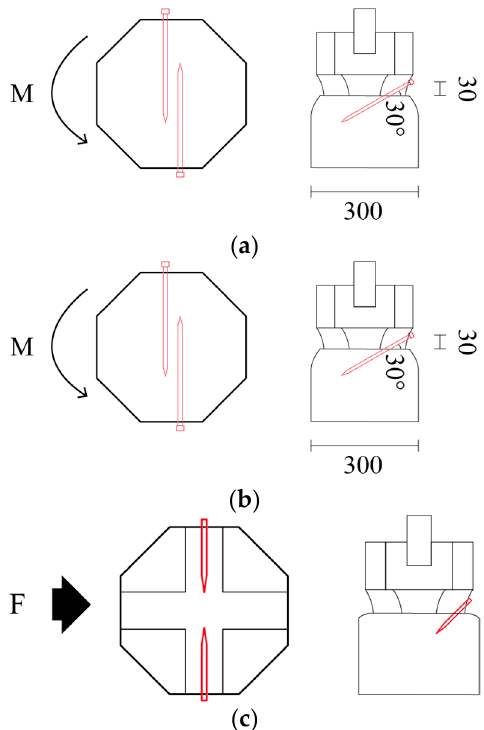
Figure 6. Schemes of retrofitting techniques: ( a ) shear-constraining by STS; ( b ) moment-constraining by STS; ( c ) shear-constraining by bamboo.